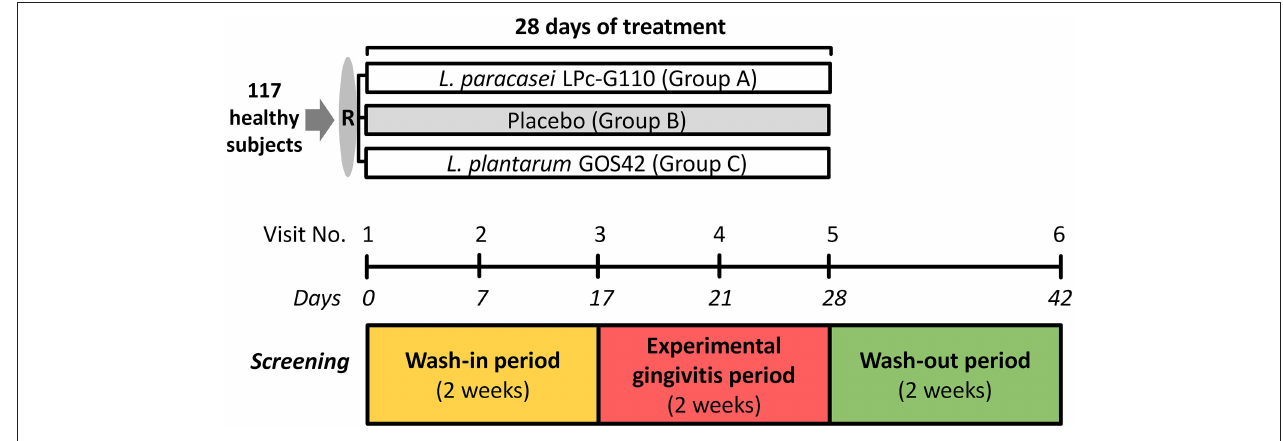
FIGURE 1 | Study outline. R –